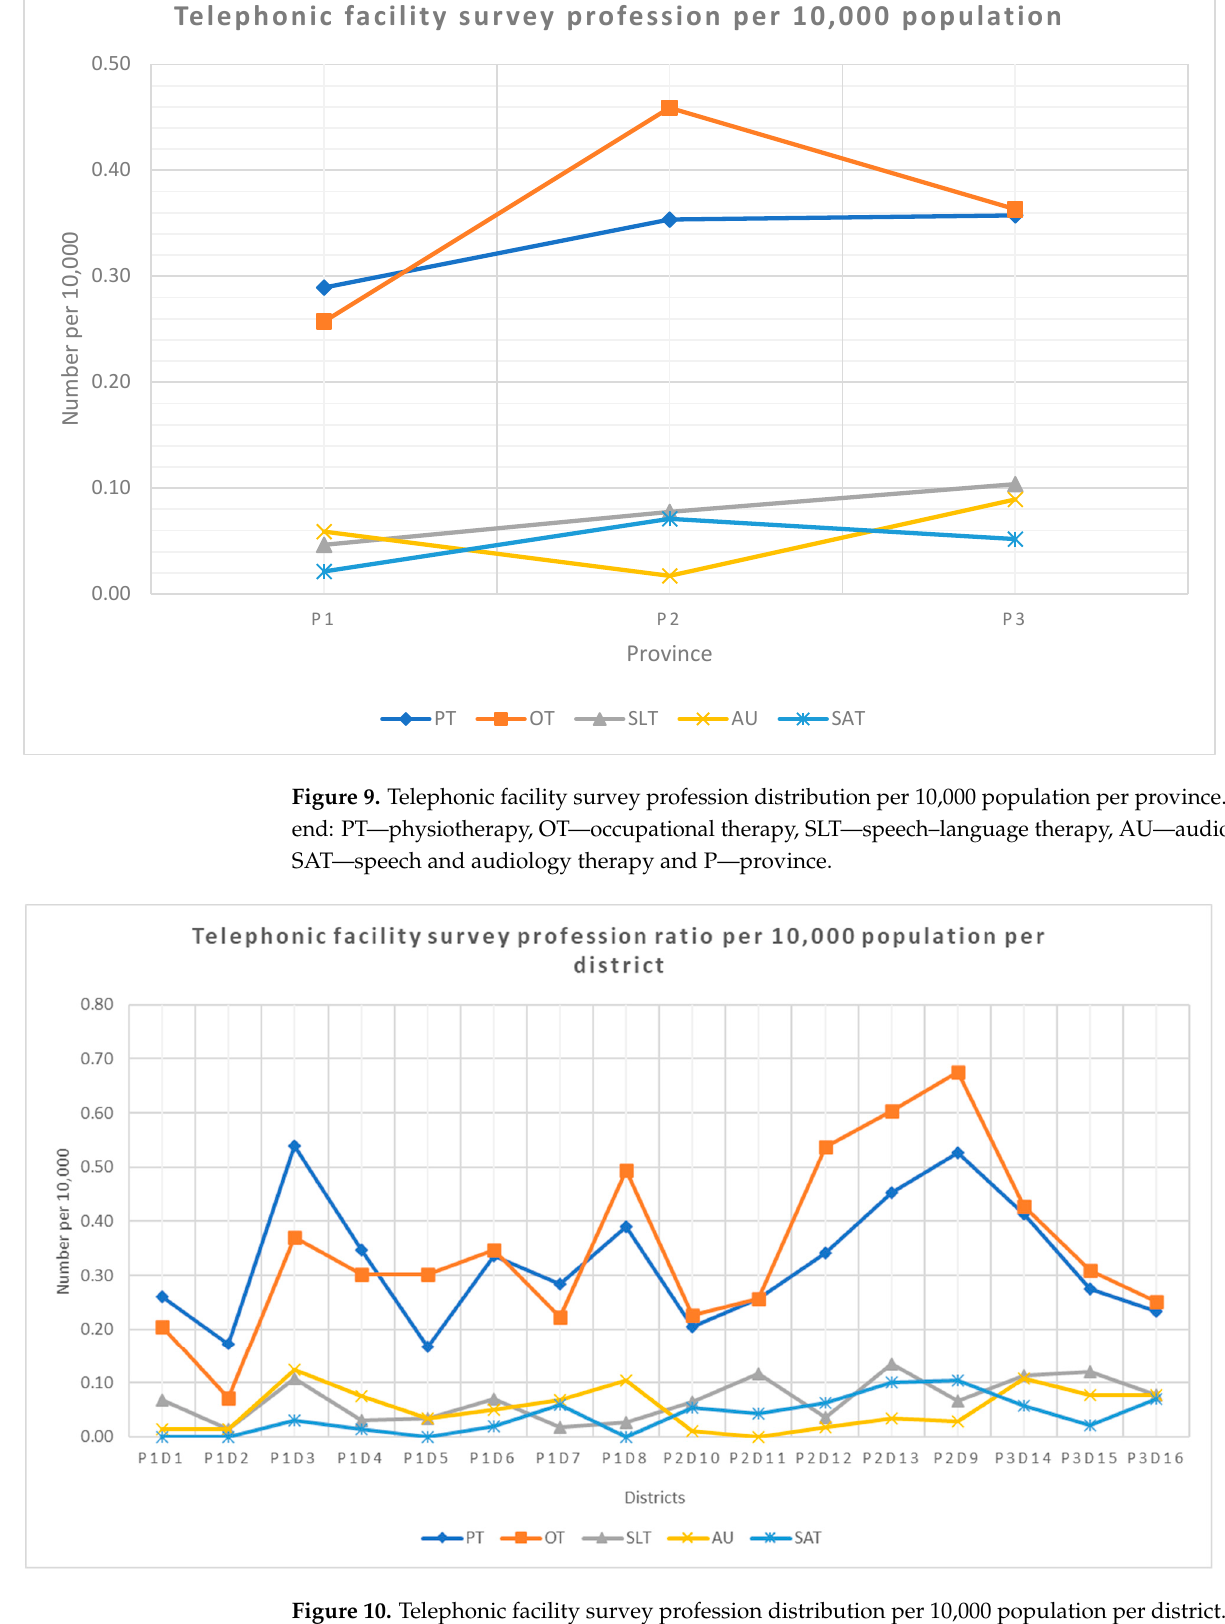
Figure 10. Telephonic facility survey profession distribution per 10,000 population per district. Leg- end: PT—physiotherapy, OT—occupational therapy, SLT—speech–language therapy, AU—audiology, SAT—speech and audiology therapy and P—province and